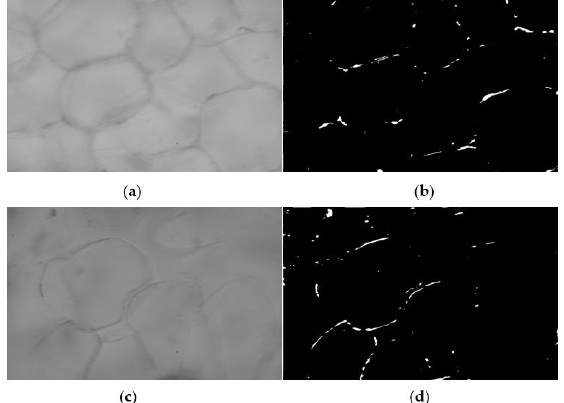
Figure 4. Example of quantile thresholding ( a ) normalized average band image of 530 nm and 680 nm for a blueberry with firmness 7.93 N, ( b ) 1% quantile thresholding results from ( a , c ) normalized average band image for a blueberry with firmness 2.31 N, ( d ) 1% quantile thresholding results from ( c ).